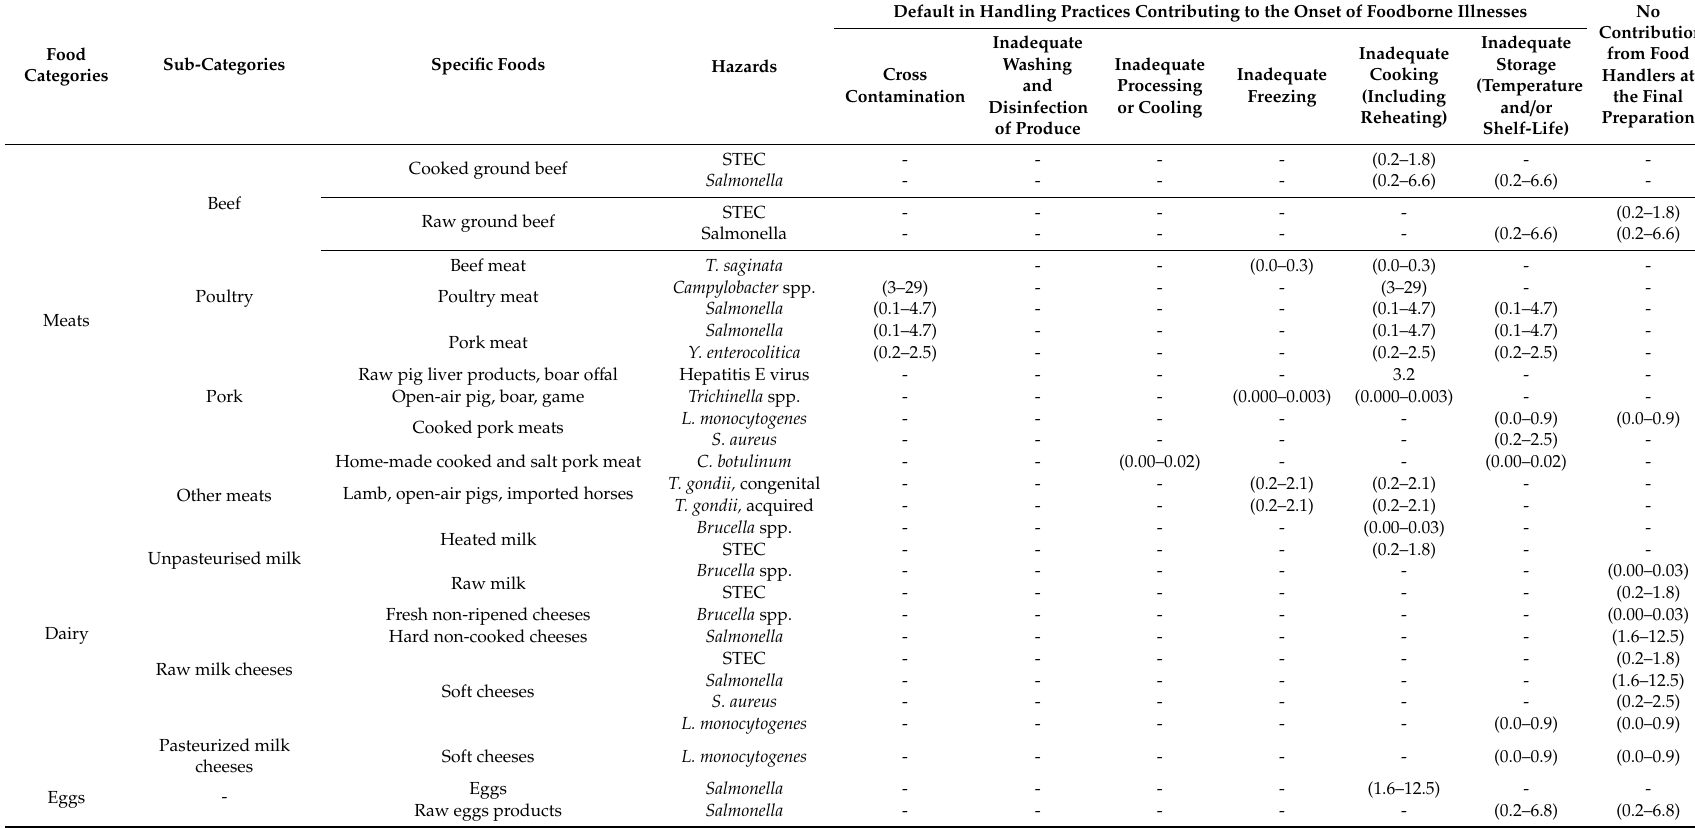
Table 3. Foodborne disease burden (90% uncertainty intervals) for exposure routes and food-handling practices implicated in the transmission of biological foodborne